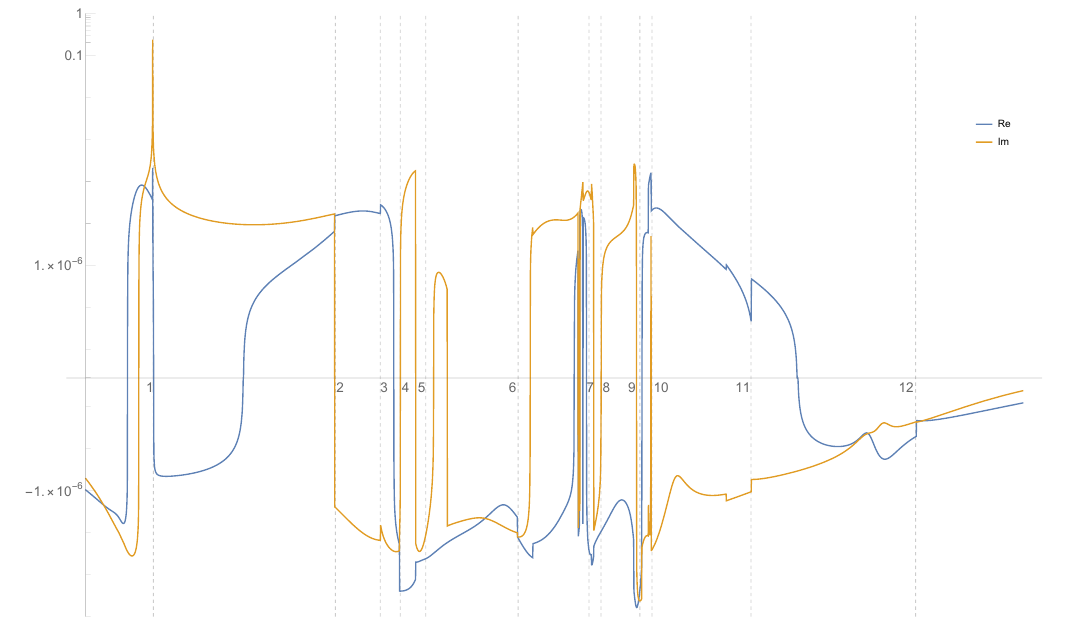
Figure 13. The real (blue) and imaginary part (yellow) of the integrand multiplied by the Jacobian of the contour deformation along a line segment (see (cid:12)gure 11) on a symmetric log y-axis: at annotated point 1, the line crosses a focal point. There, the integrand has an integrable singularity. Features 2 to 12 are crossings with the line and the points, where either the real or the imaginary part of the deformed E-surface vanishes. On these intersections the deformation vector (cid:12)eld ~(cid:20) is non-smooth (see (cid:12)gure 12), which induces discontinuities in the Jacobian of the contour deformation.